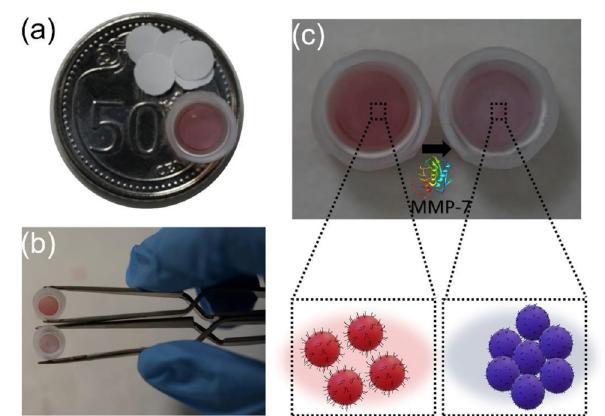
Figure 4. ( a ) Comparison of the size of the membrane with respect to a 50 cents coin, and ( b ) photograph and ( c ) schematics of the assay with peptide functionalized AuNPs on PVDF membrane, which yields a change in color from reddish to violet, due to aggregation induced by MMP-7. The MMP-7 peptide substrate functionalized AuNPs were deposited on PVDF membrane. The AuNPs aggregate on PVDF membrane because of increased electrostatic interparticle attraction upon proteolysis by MMP-7. (Adapted from Goyal et al. 2020 [98], Copyright 2019 Elsevier B.V. and reproduced with